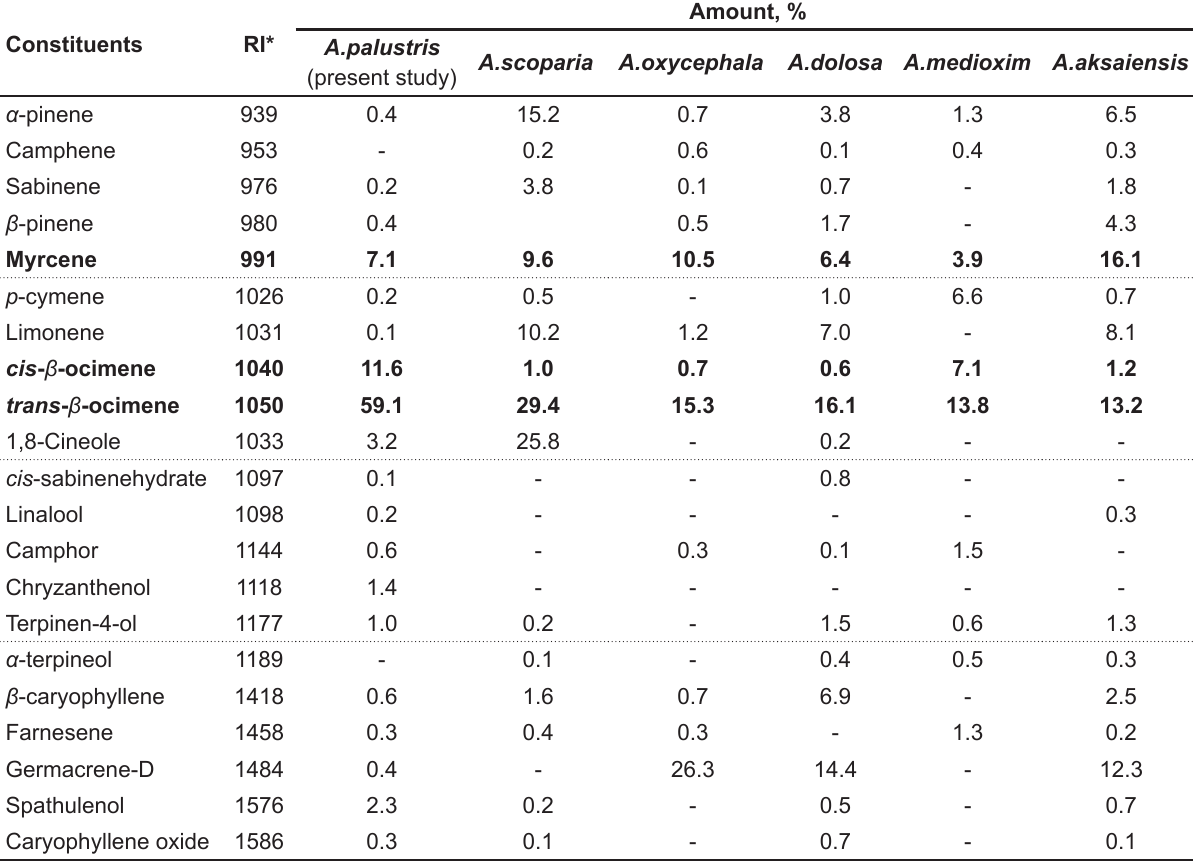
Table 2. Chemical constituents in some Artemisia essential oils rich with β -ocimene